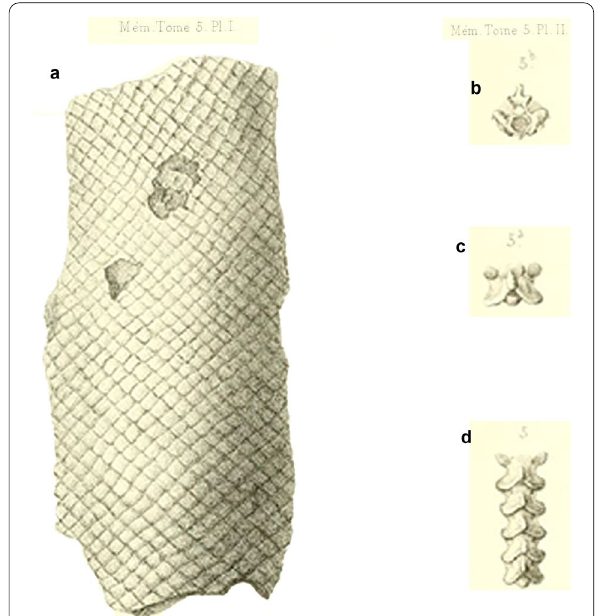
Fig. 39 Original lithograph of the type material of “ Palaeopython ” neglectus from imprecisely known localities in the Phosphorites du Quercy: a paralectotype “mummy” (MNHN.F QU16324) in dorsal view; b , c lectotype trunk vertebra (MNHN.F QU16326) in anterior ( b ) and dorsal ( c ) views; ( d ) paralectotype five articulated trunk vertebrae in dorsal view. Image modified from plate II of Rochebrune